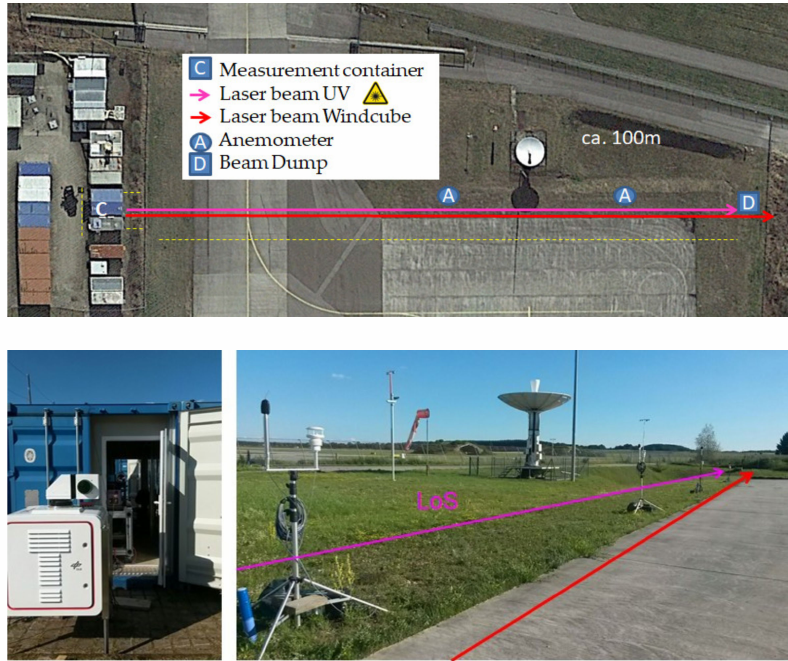
Figure 7. Setup of the ground test campaigns in 2017 and 2018.